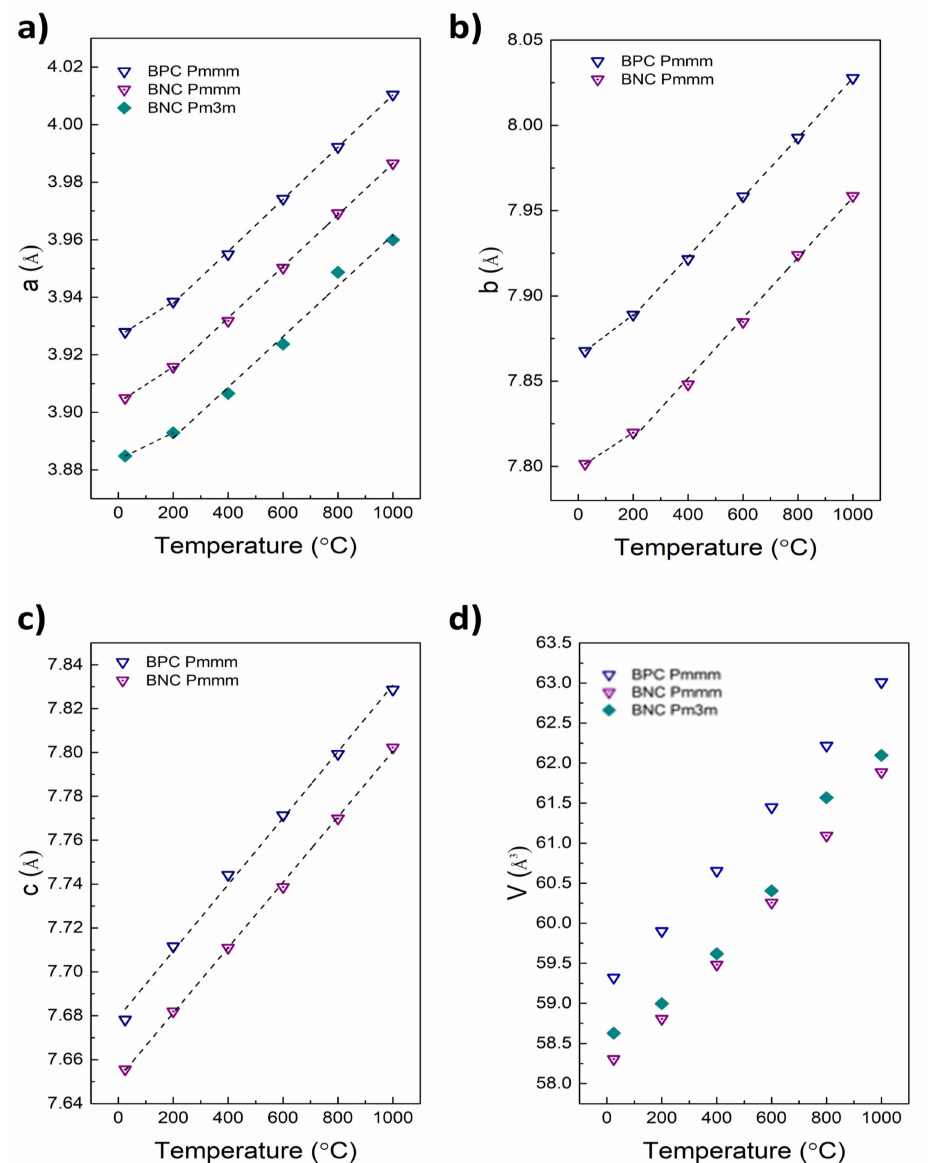
Figure 4. Temperature dependence of lattice parameters and unit cell volume of BPC and